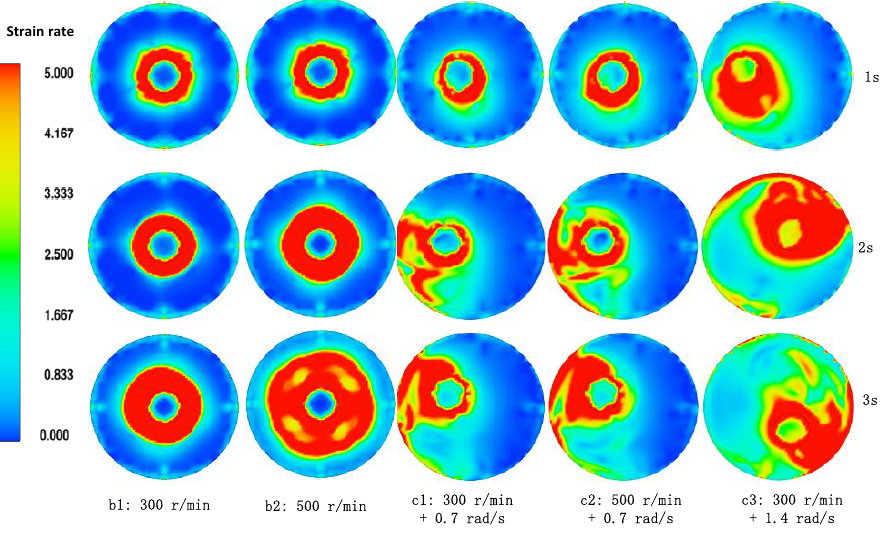
Figure 3. Melt strain rate of planetary mixing and stirring